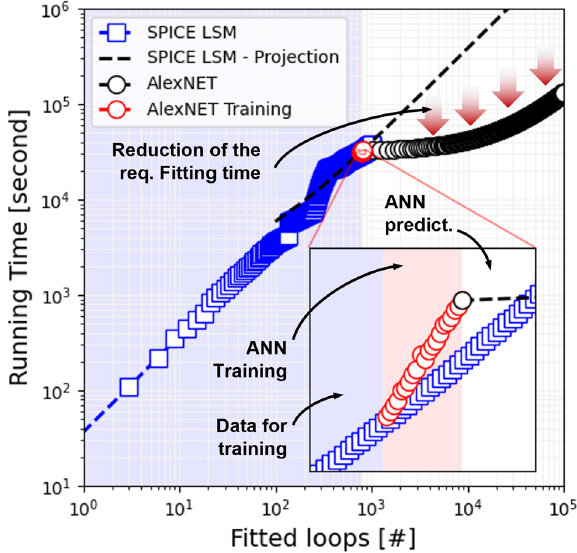
Figure 9. Evaluation metrics of the proposed parameter extraction technique using ANNs. Time required to fit an increasing number of I-V loops using the simulator-in-the-loop, iterative approach, and the ANN-based counterpart. For a large number of loops (e.g., 100,000), the ANN approach allows a significant time saving.